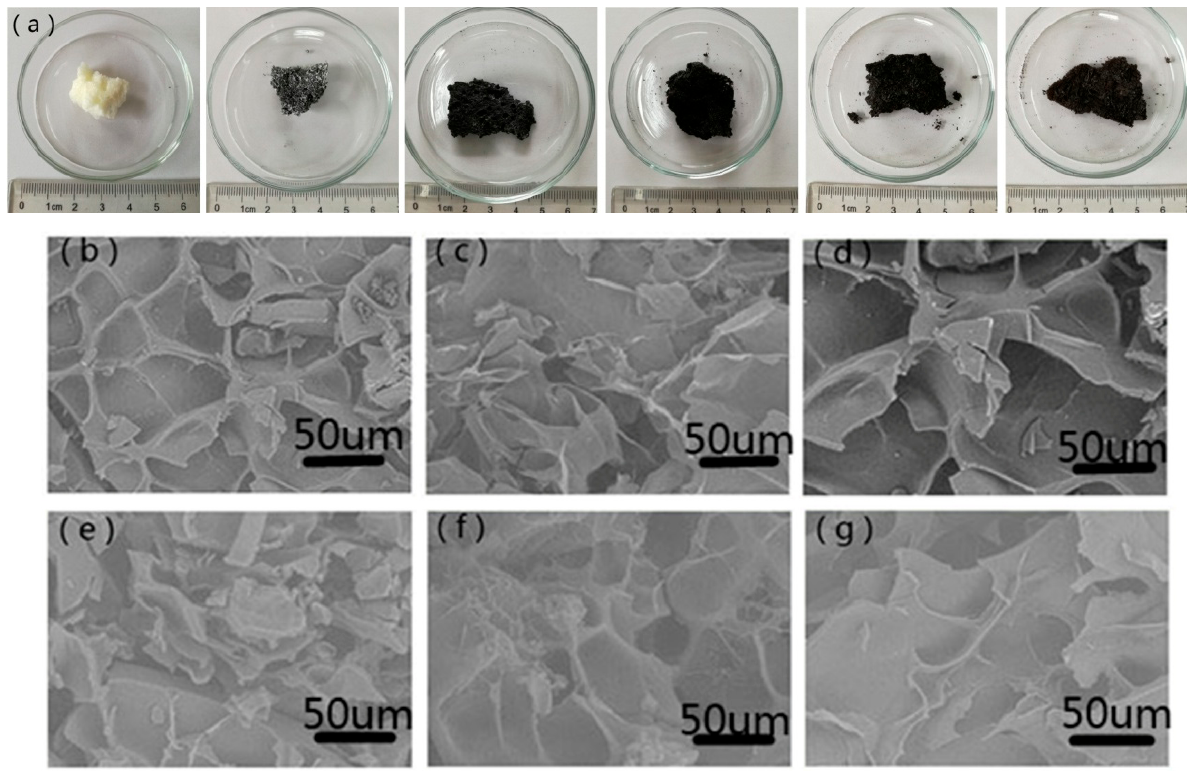
Figure 1. ( a ) The optical photographs of PGO aerogels, SEM images of PGO aerogels: ( b ) PGO-0, ( c ) PGO-10, ( d ) PGO-30, ( e ) PGO-50, ( f ) PGO-70, and ( g ) PGO-90. The FTIR spectra of PGO-0, GO and PGO-30 aerogels were measured, as shown in Figure 2a. There are peak values at 3420, 2980, 1640, 1520, 1260 and 1050 cm − 1 in the FTIR spectrum of PGO-0, corresponding to O–H, C–H, C=C, N–H, C=C, and C–O flexion and extension vibration, respectively [33]. The FTIR spectra of GO contain peaks of 3400, 1710, 1630, 1420 and 1070 cm − 1 , corresponding to flexion and extension vibration of O–H, C=O, C=C and C–O, respectively [34]. All peaks in FT-IR spectra of PGO-0 and GO appear in the FT-IR spectrum of PGO-30 aerogels, indicating that the egg white protein combine well with GO to form a novel